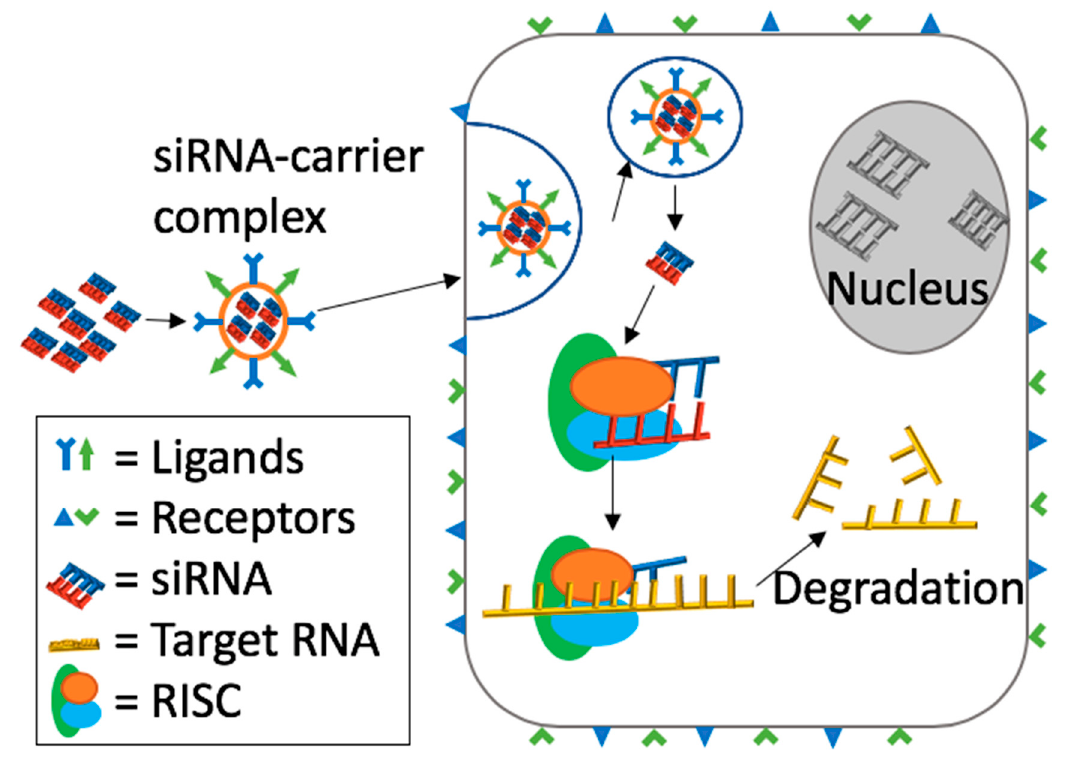
Figure 8. General mechanism of ligand-receptor mediated targeting and siRNA delivery. Figure